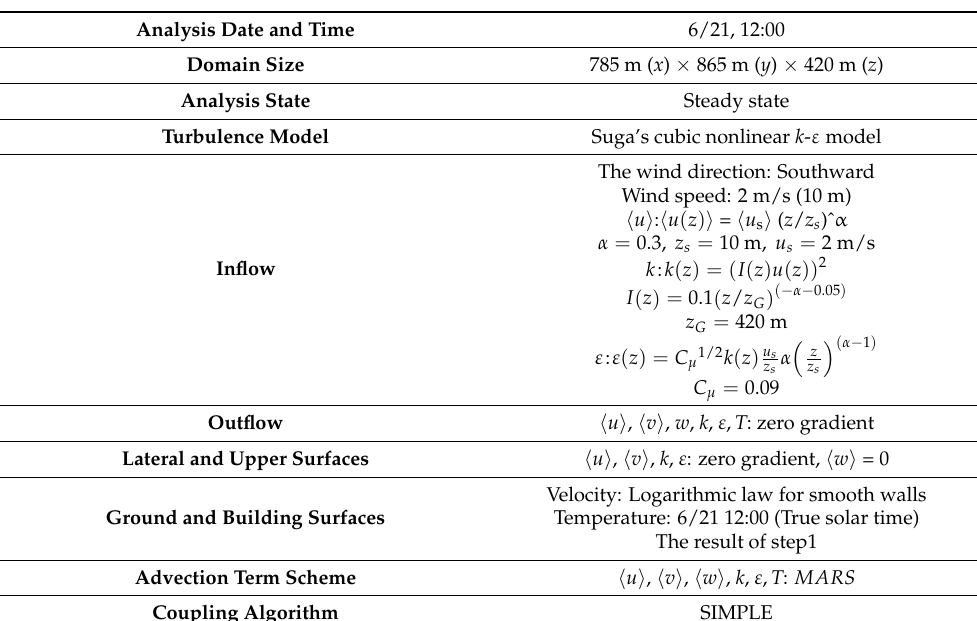
Table 5. Analysis conditions in Step